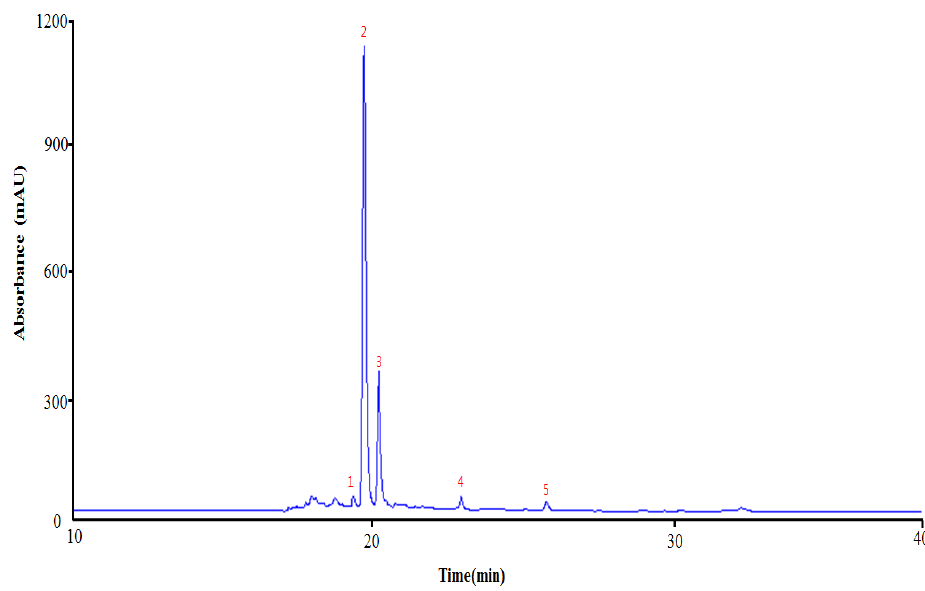
Figure 1. High performance liquid chromatography (HPLC) profile of flavonoids identified from Citrus unshiu peel. Note: (1) Rutin, (2) Naringin, (3) Hesperidin, (4) Poncirin, and (5) Unknown. Table 1. HPLC-MS/MS (retention time, m/z fragments) parameters of standards used for identification of flavonoids in Citrus unshiu peel (CUP). Peak.